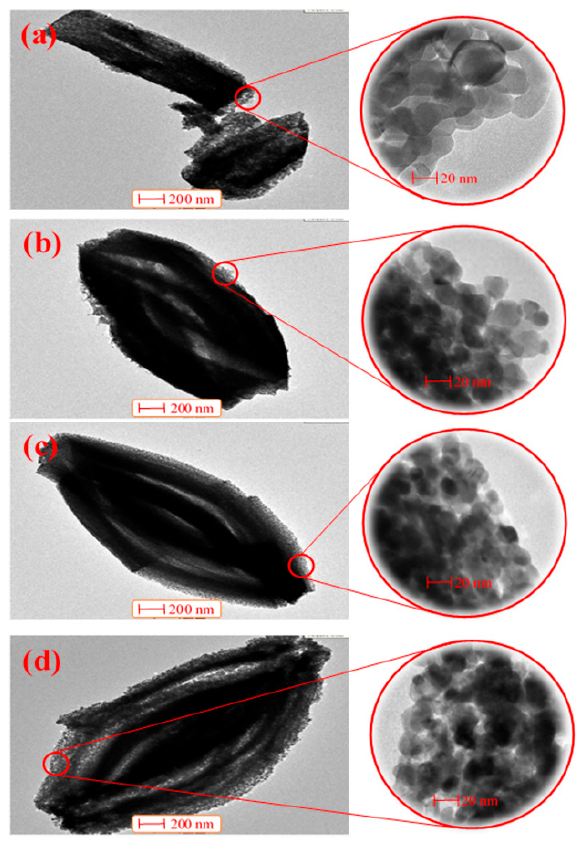
Figure 5. TEM images of the calcined NiO. ( a ); Gd/NiO ( b ); La/NiO ( c ); and Sm/NiO ( d ). Textural characteristics of the prepared catalysts were investigated by nitrogen sorption analysis.